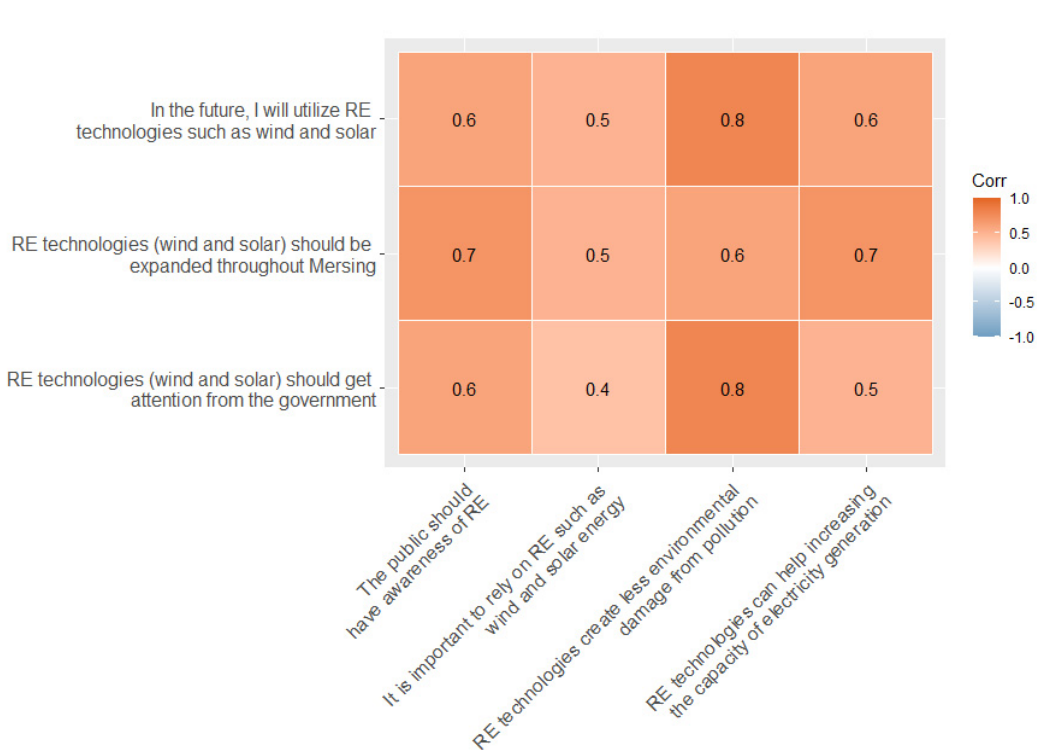
Figure 17. The Mann–Whitney U test ( p ‐ value) between the items in knowledge and awareness of RE and desire and acceptance of RE. 6. Conclusions and Policy Implications The view of the public on wind and solar resources is a big obstacle to the growth of RE technology in Malaysia. The goal of this research is to assess RE technologies in Kampung Tanjung Resang, Mersing, in terms of rural public acceptance. A survey was carried out by this study both before and after the wind PV hybrid device was installed. On the basis of this study, it was discovered that most of those interviewed were positive and accepted RE technologies. The overall results